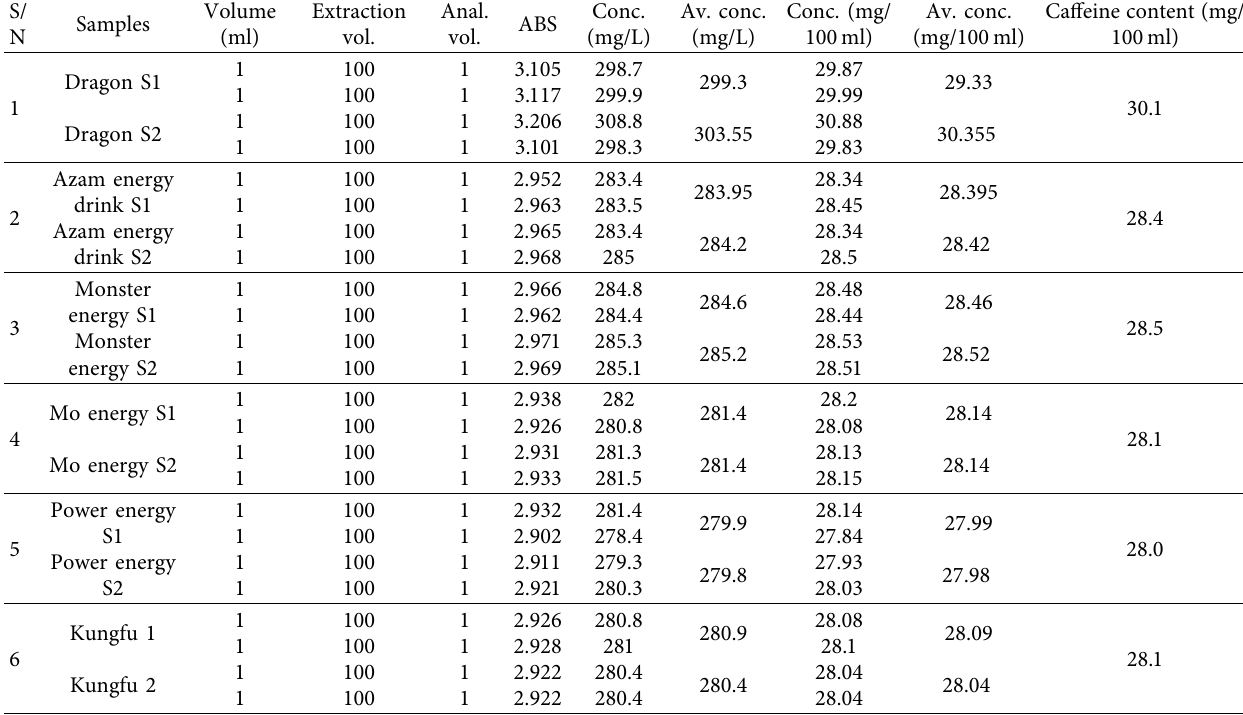
Table 3: Results on cafeine contents samples (beverages) analyzed in duplicate (S1 and S2) during a study to assess energy drink consumption rate, knowledge, and perceived side efects among long-distance car drivers in Morogoro municipality, Morogoro, Tanzania, 2018-2019.